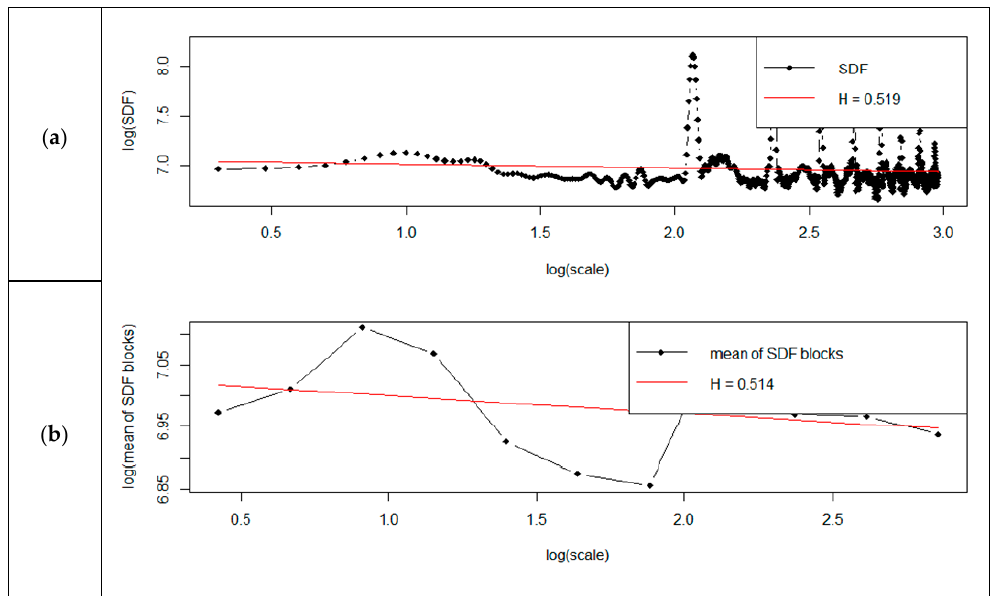
Figure 13. Spectral regression graph by Welch method: ( a ) the standard method, ( b ) the smoothed method.